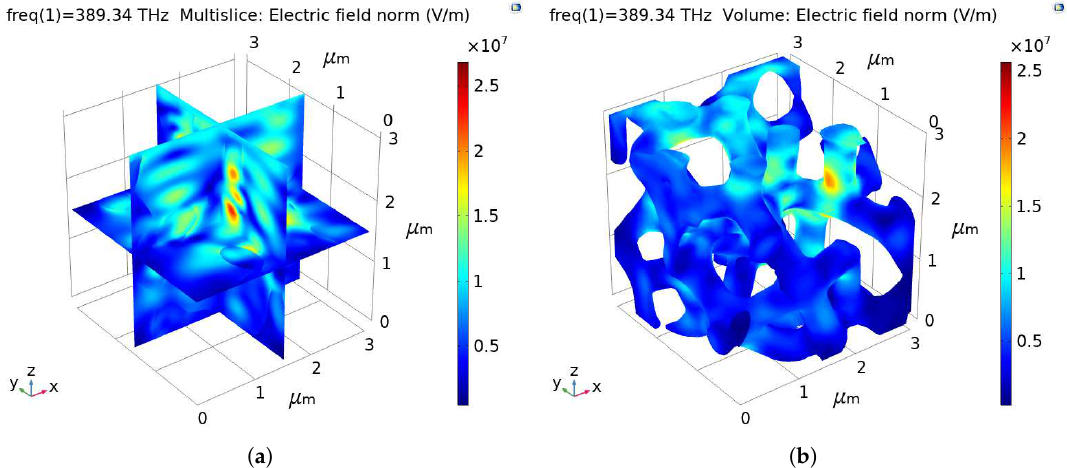
Figure 4. Illustration of the EFNof the sample RVE: ( a ) in the multislice perspective and ( b ) the EFN of the porous model.